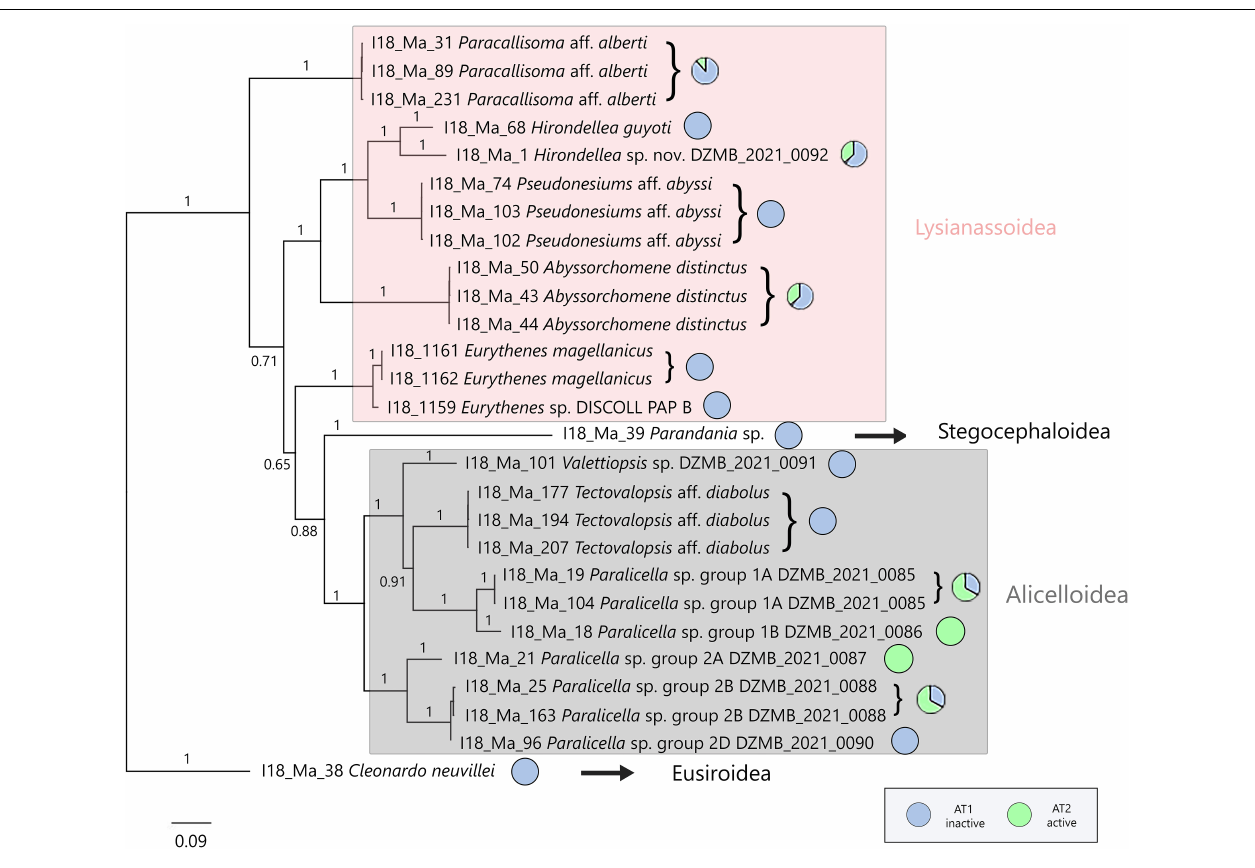
FIGURE 5 | Bayesian inference tree construction on the concatenate three-gene dataset (COI, 16S rDNA, 18S rDNA). The distances were calculated with the General Time Reversible model (COI, 18S) and the Hasegawa-Kishino-Yano model (16S). Numbers represent posterior probabilities. Next to the tree information about the relative abundances for the two locations are given. The superfamilies are indicated on the